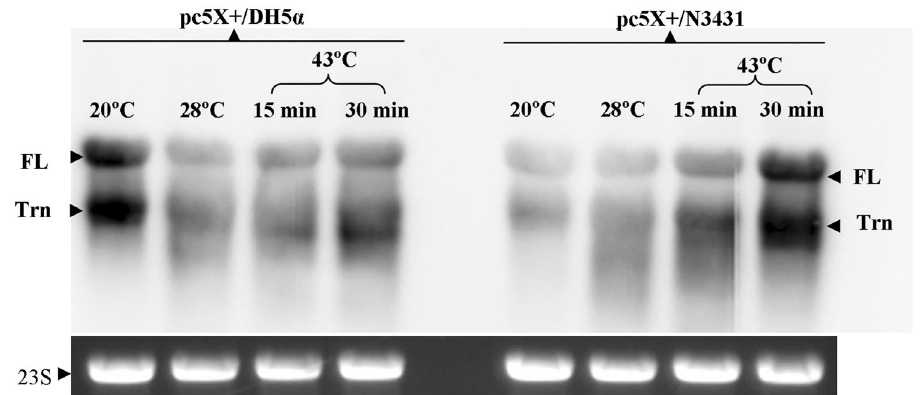
Figure 4. Northern blot image showing fate of chimeric ACLSV MP mRNA in E. coli DH5 α (left panel) and in rne ts mutant (right panel). The chimeric plasmid pc5X + was transformed into DH5 α cells ( pc5X + /DH5 α ) and into rne ts ( pc5X + /N3431). Total RNA was used for northern blotting. The DH5 α panel shows higher accumulation of both full-length (FL) and truncated (Trn) transcripts at 20 °C as compared to 28 and 43 °C samples. On the other hand, there is more accumulation of FL in sample collected after 30 minutes of shifting to non-permissive temperature (43 °C) compared to FL at 20 °C, 28 °C (permissive temperature) and 15 min sample of 43 °C (non-permissive temperature) in pc5X + /N3431 samples. EtBr stained 23 S ribosomal RNA (internal loading control) has been shown as a separate panel in the above image. The 23 S image is cropped from the total RNA image which is presented as a full length image in supplementary Figure